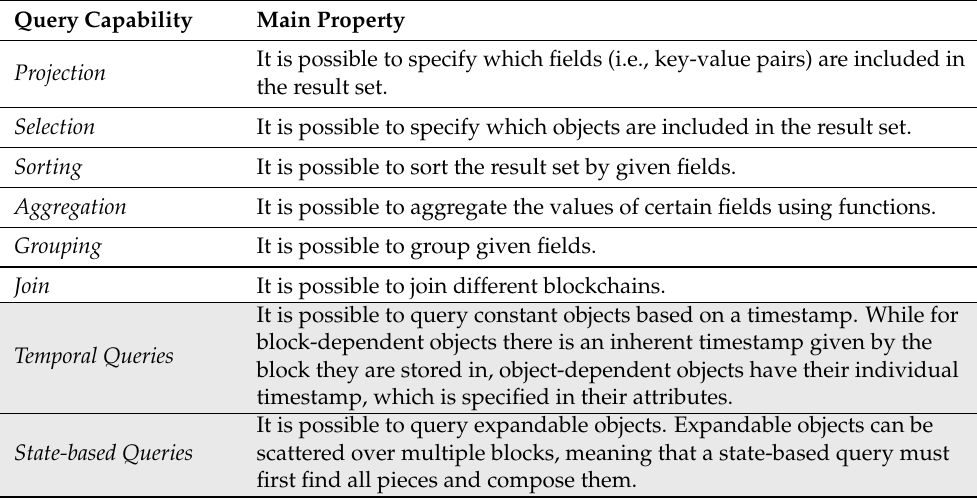
Table 3. Overview of the six basic query operators (white rows) and two blockchain-specific query capabilities (gray rows) derived from the presented application